Question: Write the caption for this figure.
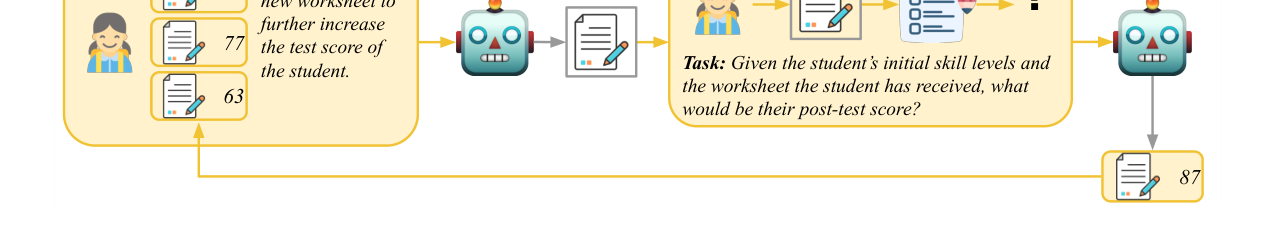
Answer: We use an optimizer LM to generate new educational materials (e.g., worksheets) and an evaluator LM to judge the effectiveness of these materials by predicting students’ post-test performance. In this example, the optimizer LM generates a new worksheet based on the student information and previous worksheet-score pairs, then the evaluator LM predicts the student’s post-test score given the new worksheet. The new worksheet-score pair serves as feedback for the optimizer LM to refine worksheets.